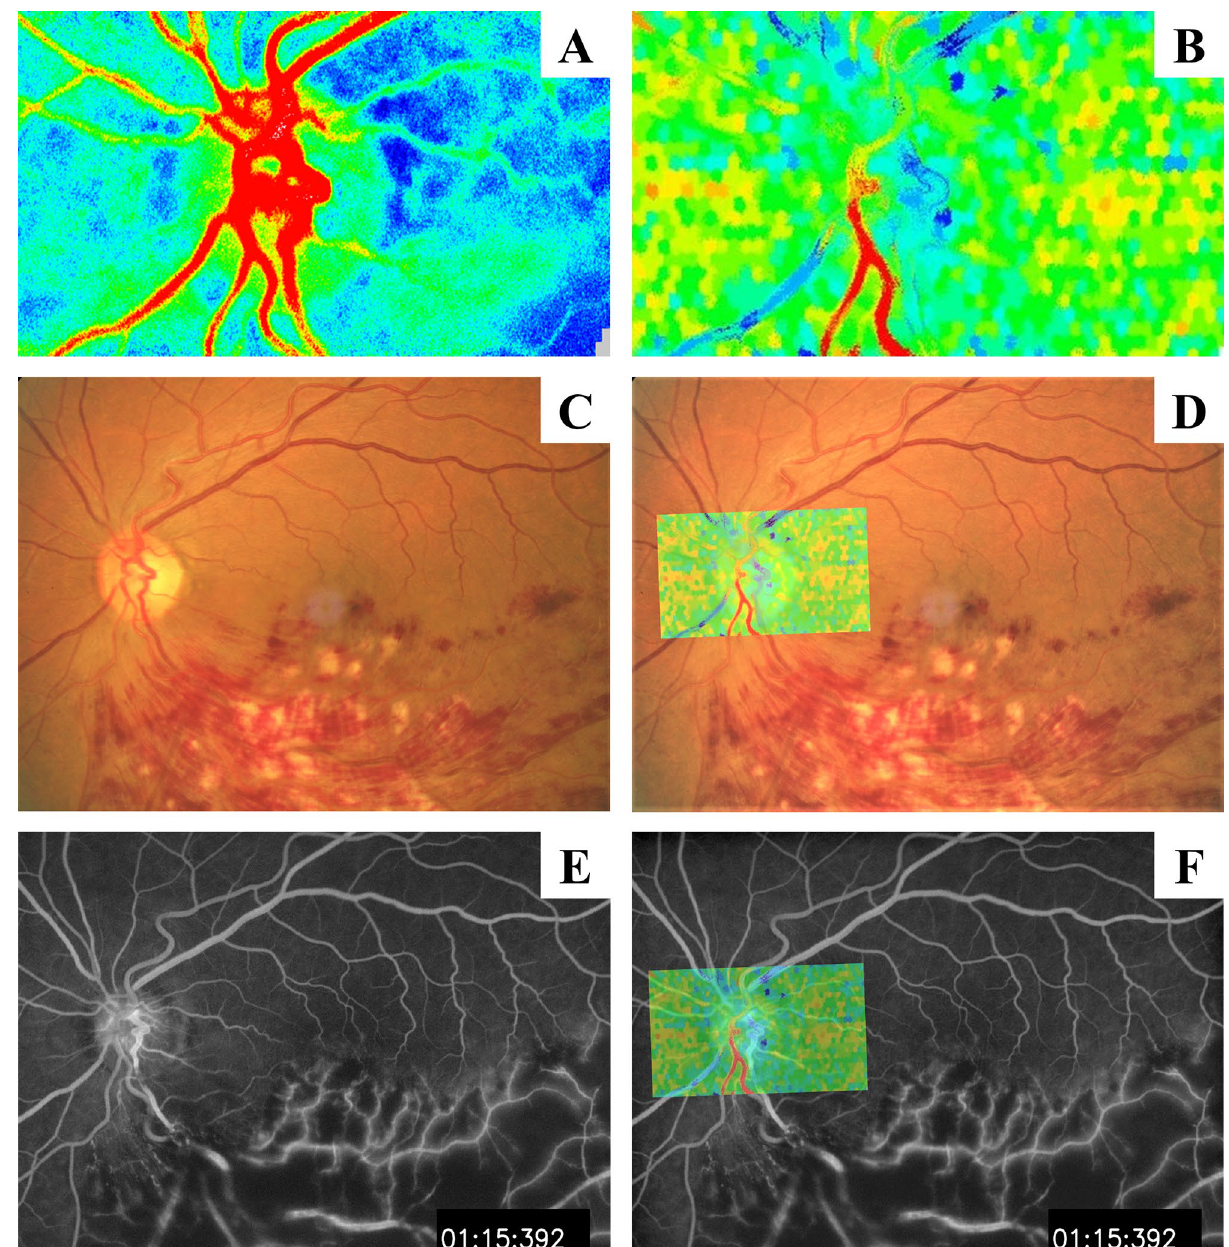
the affected retinal area. ( C , D ) Fundus photograph of the BRVO-affected eye and superimposed image with BOM map. ( E , F ) Fluorescein angiogram and superimposed image with BOM map showing nonperfusion of